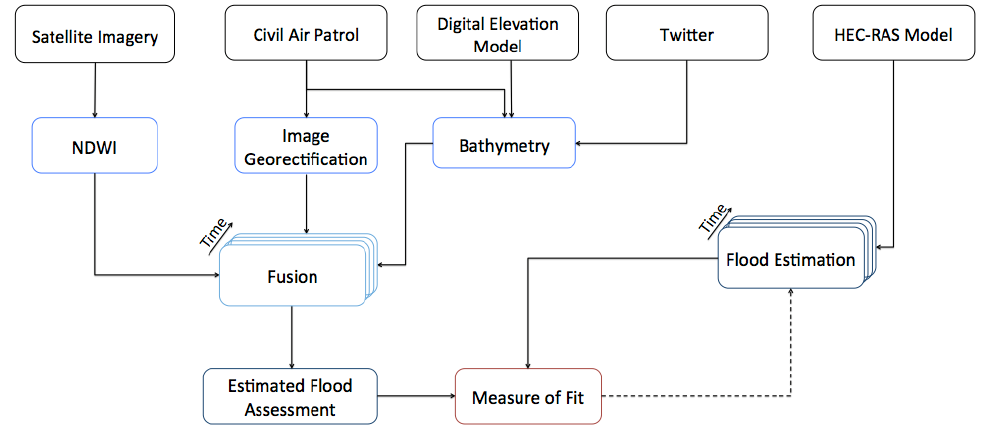
Figure 3. Diagram of the methodology used in this study to generate flood change detection